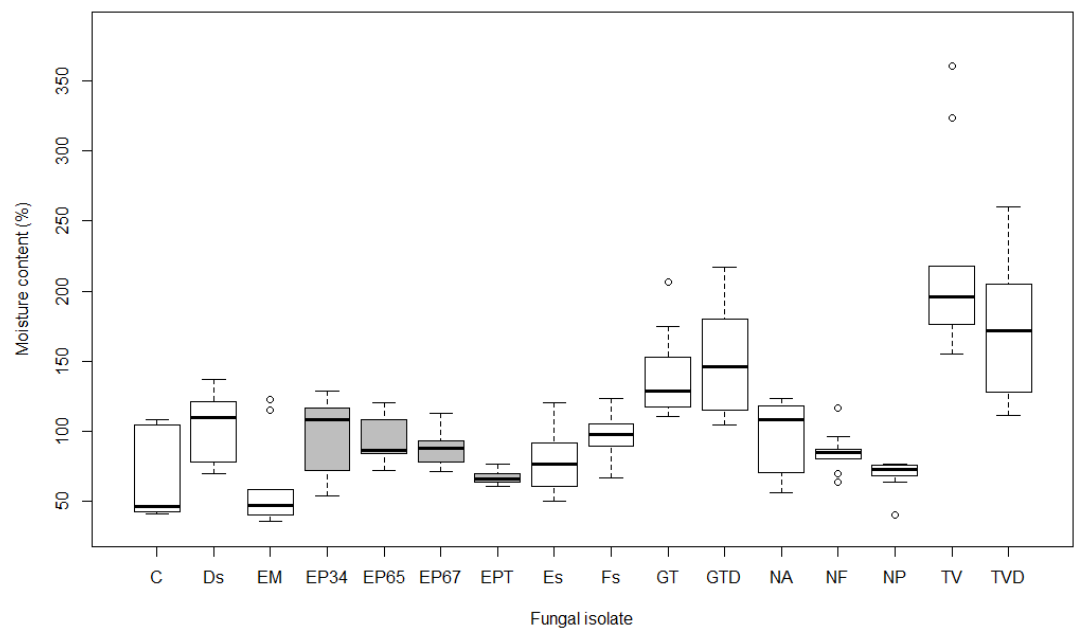
Figure 5. Boxplots showing moisture content (%) after 15 weeks of exposure to different fungal isolates in Acer platanoides (see Table 1 for labels of isolates; boxes of E. parasitica isolates are grey). Boxplot represents minimum, first quartile (Q 1 ), median, third quartile (Q 3 ), and maximum value.